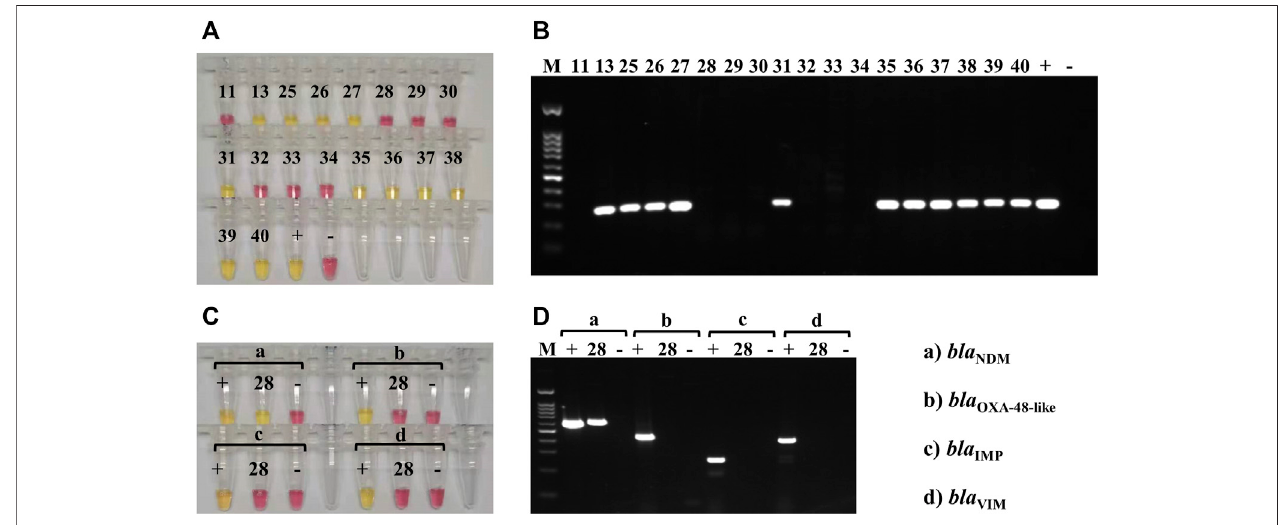
FIGURE 5 | Carbapenemase-producing genes LAMP and PCR testing on clinical sputum samples. (A) Colorimetric LAMP results, targeting the bla KPC gene, obtained on DNA extracted from the 18 clinical sputum samples that contained K . pneumoniae (according to MALDI-TOF); 11 of the samples were bla KPC -positive (yellow;13,25 – 27,31,and35 – 40),and7werenegative(pink).DNAextractedfrom K.pneumoniae HS11286wasusedasapositivecontrol(+),andthenegativecontrol ( − ) was molecular-grade H 2 O. (B) PCR results, for bla KPC ampli fi cation, obtained on DNA extracted from the 18 clinical sputum samples that contained K . pneumoniae (sameasA);11ofthesampleswere bla KPC -positive(ampli fi cationbands;13,25 – 27,31,and35 – 40),and7werenegative(noband).DNAextractedfrom K. pneumoniae HS11286 was used as positive control (+), and the negative control ( − ) was molecular-grade H 2 O. The marker (M) was a 100-bp DNA ladder. (C) Colorimetric LAMP results, targeting the bla NDM (a), bla OXA-48like (b), bla IMP (c), and bla VIM (d) genes, obtained on the DNA extracted from sample 28. Positive controls (+) and negative controls ( − ) were used for each assay. Sample 28 was positive (yellow) for bla NDM (a) and negative (pink) for the other carbapenemase- producing genes (b – d). (D) PCR results, targeting the bla NDM (a), bla OXA-48like (b), bla IMP (c), and bla VIM (d) genes, obtained on the DNA extracted from sample 28. Positivecontrols(+)andnegativecontrols( − )wereusedforeachassay.Sample28waspositive(ampli fi cationbandat621 bp)for bla NDM (a)andnegative(noband) for the other carbapenemase-producing genes. The marker (M) was a 100-bp DNA